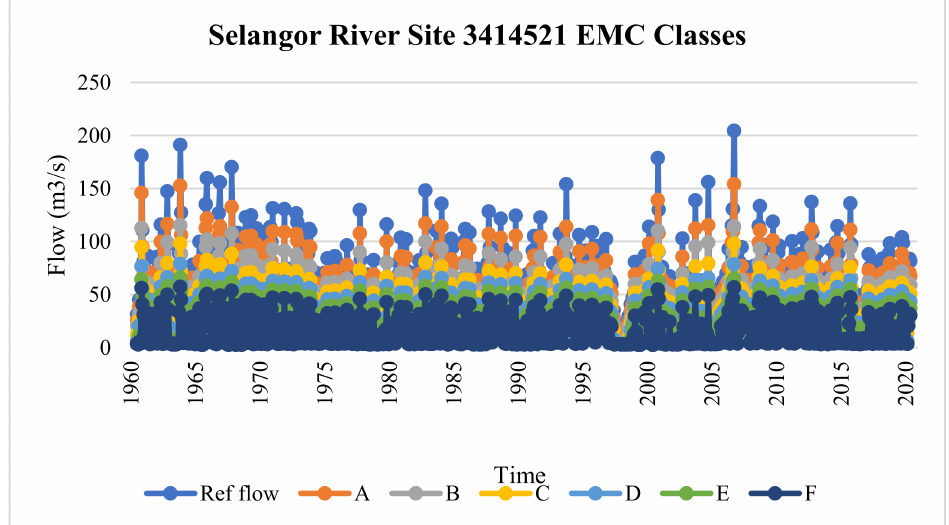
Figure 6. GEFC analyzed Environmental Management Classes under different degrees of modifications.